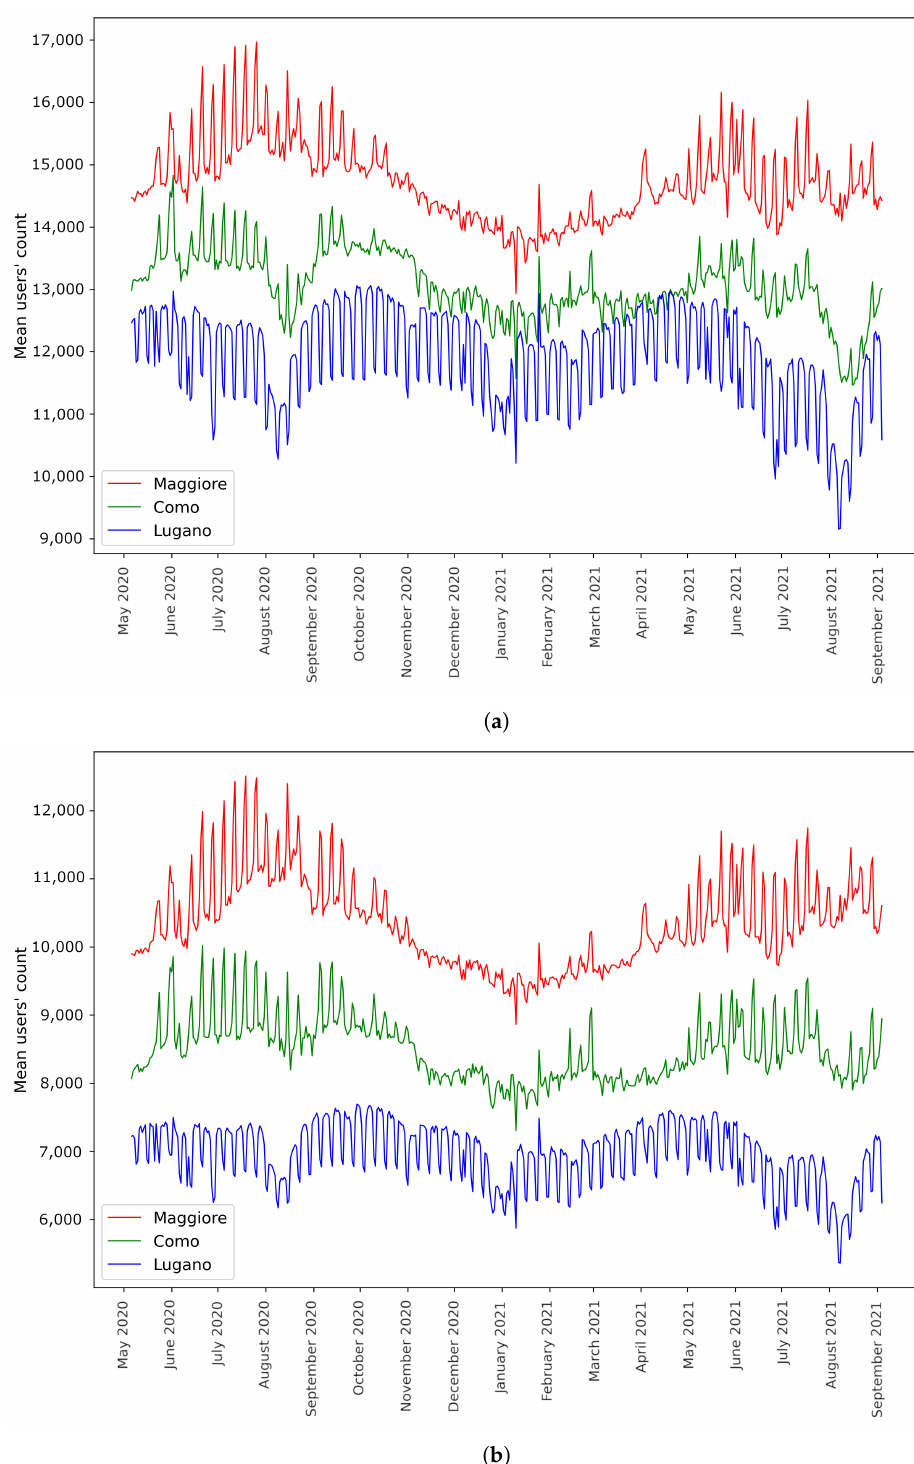
Figure 2. Time series of the daily mean Facebook users’ population counts by lake within the 5 km ( a ) and 2 km ( b ) buffer areas surrounding the considered lakes for the study period 6 May 2020–31 August